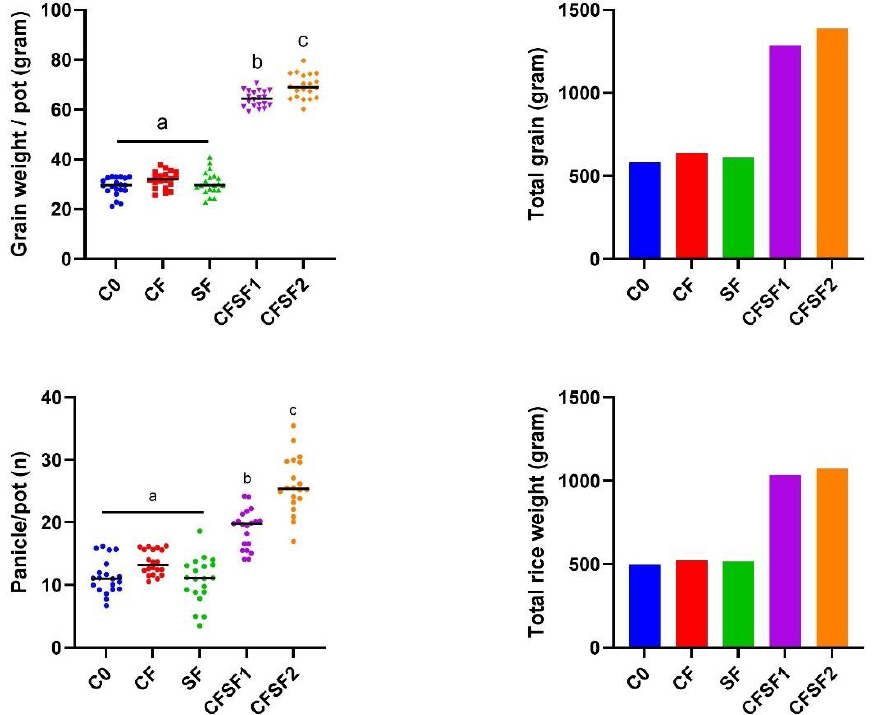
Figure 3. The effects of SF on paddy grain and rice yield. Different annotation letters indicate significant difference ( p < 0.01) between groups.